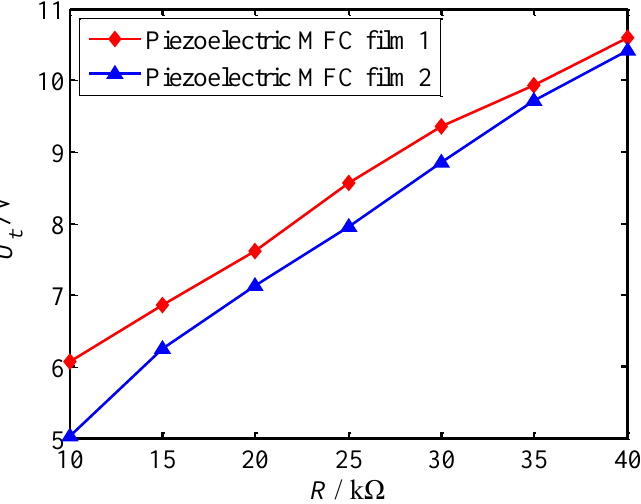
Figure 7. Output voltage varies with load resistance under transient excitation.